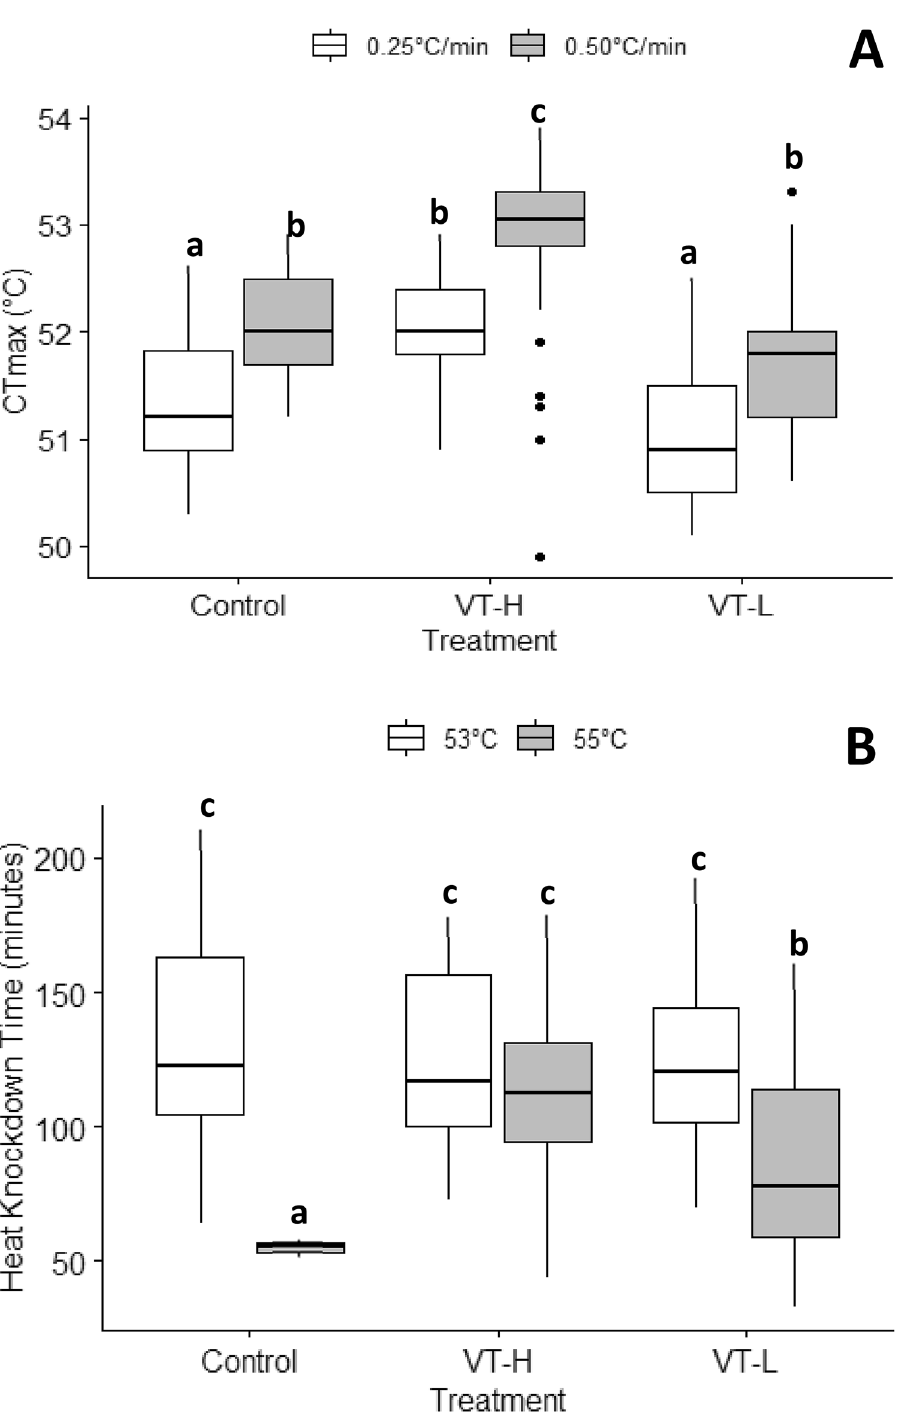
Figure 1. The effect of ramping rate and variable temperature acclimation on ( A ) critical thermal maxima (CT max ) and, ( B ) heat knockdown time (HKDT) at 53 °C and 55 °C. Each point represents mean ± SEM and median ± SE for ( A ) and ( B )